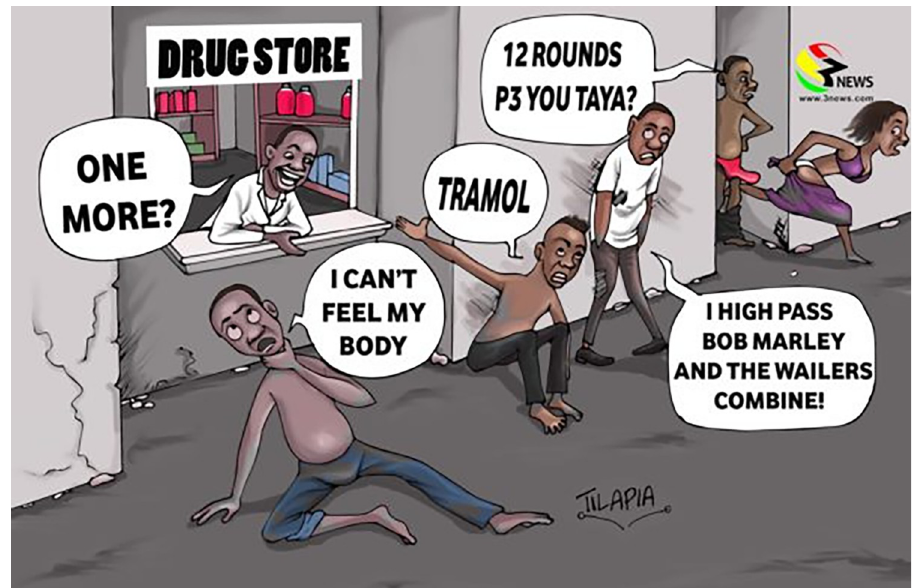
Fig 2. The tramadol sex street. Cartoon by Ghanian artist Tilapia da Cartoonist, April 2018. Reproduced with permission from Tilapia da Cartoonist.